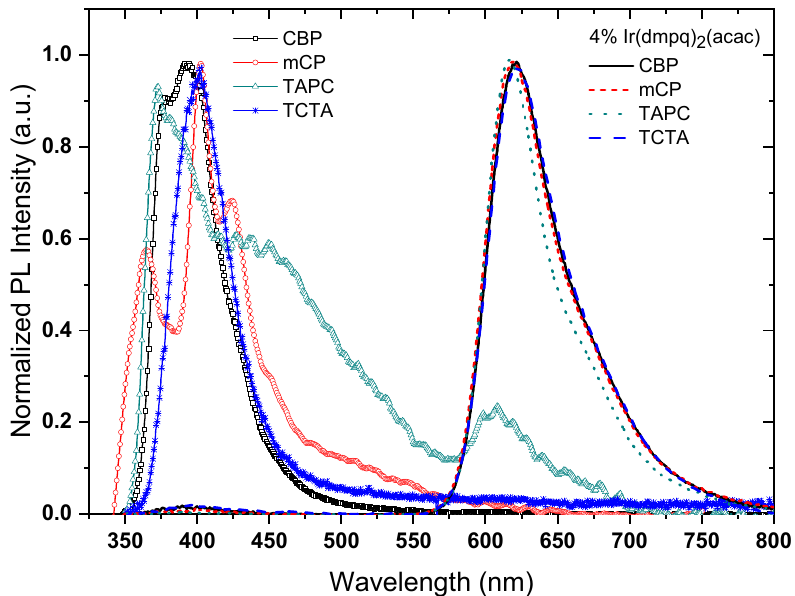
Figure 3. The normalized PL spectra of the Host:Ir-complex films in comparison to the net hosts.